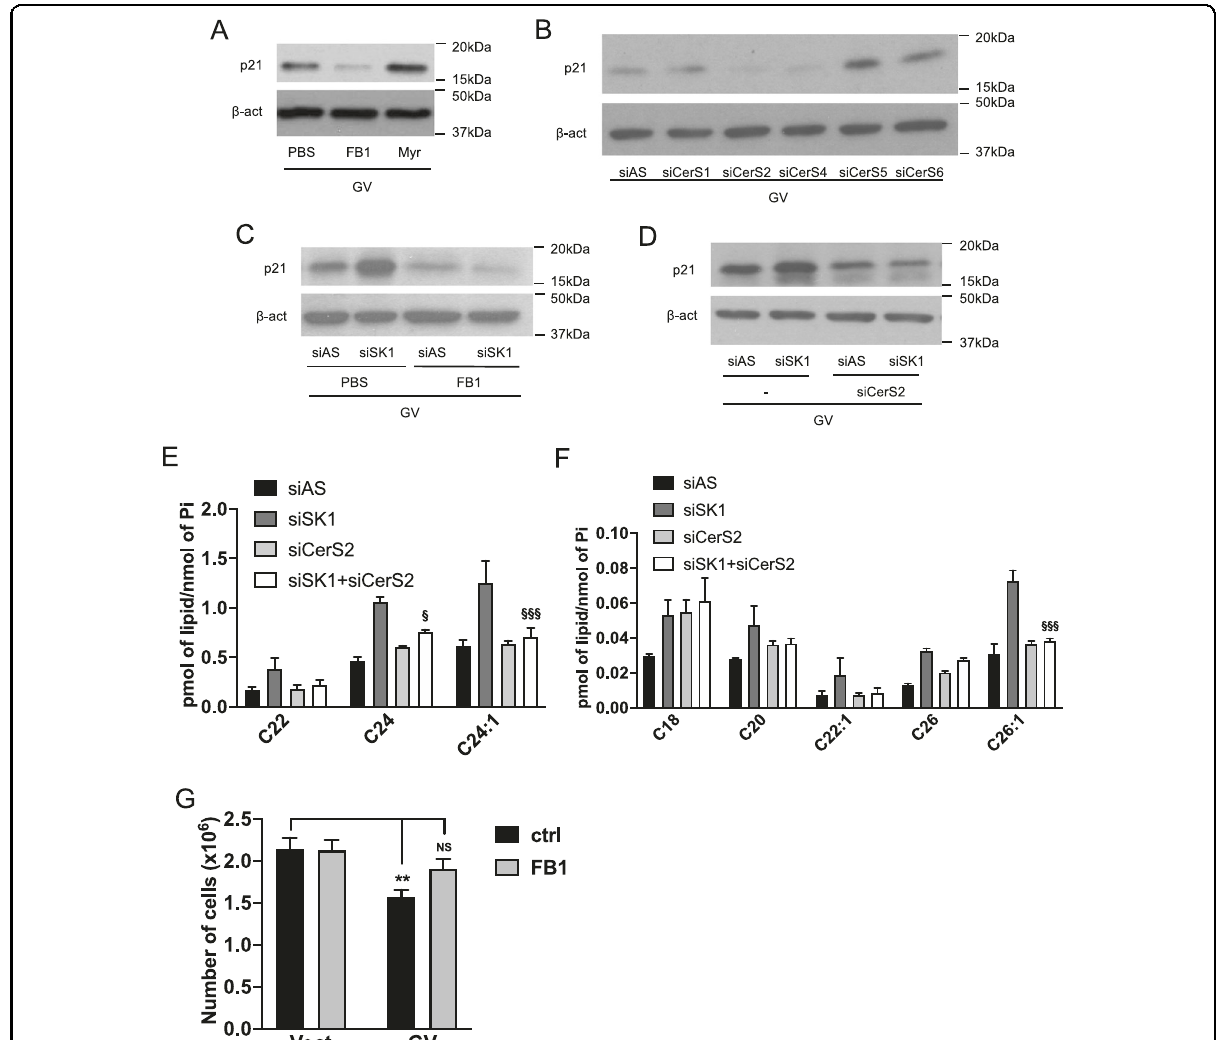
Fig. 8 Ceramide synthases, especially CerS2, drive oncogenic K-Ras-induced senescence and mediate the increase of senescence induced by SK1 downregulation. A Western blot analysis of p21 expression in cell lysates from cells overexpressing GV K-Ras. Cells were plated and treated the next day with Fumonisin B1 (FB1) or Myriocin (Myr) for 72 h at 1 μ M or 100 nM fi nal, respectively. Cells were then lysed and the protein level of p21 was determined. B Western blot analysis of p21 expression in cell lysates from cells overexpressing GV K-Ras. Cells were plated and transfected the next day with control (AS) or CerS1-6 siRNA (20 nM) for 72 h. Cells were then lysed and the protein level of p21 was determined. C Western blot analysis of p21 expression in cell lysates from cells overexpressing GV K-Ras. Cells were plated and treated the next day with Fumonisin B1 (FB1) and transfected with control (AS) or SK1 siRNA (20 nM) for 72 h. Cells were then lysed and the protein level of p21 was determined. D Western blot analysis of p21 expression in cell lysates from cells overexpressing GV K-Ras. Cells were plated and cotransfected the next day with control (AS) or SK1 siRNA or control (AS) and CerS2 siRNA or SK1 and CerS2 siRNA (20 nM) for 72 h. Cells were then lysed and the protein level of p21 was determined. E , F SL analysis using tandem LC/MS/MS in cells overexpressing mutant GV K-Ras. Cells were plated and cotransfected the next day with control (AS) or SK1 siRNA or control (AS) and CerS2 siRNA or SK1 and CerS2 siRNA (20 nM) for 72 h and then scraped in a lipid extraction buffer. SL levels were quanti fi ed and normalized to the amount of total lipid phosphate (N = 3, data are presented as mean ± SEM, two-way ANOVA with Dunnett ’ s multiple comparisons tests, § means p < 0.05 comparing the group GV SK1 siRNA to the group GV SK1 + CerS2 siRNA). G Cell growth analysis of cells overexpressing mutant GV K-Ras. Cells were plated and treated the next day with FB1 (1 μ M). A number of viable cells were evaluated after trypsinization every other day until 5 days in culture ( N = 5, data are presented as mean ± SEM, two-way ANOVA with Tukey ’ s multiple comparisons test, * means p < 0,05 comparing the group tested to Vector